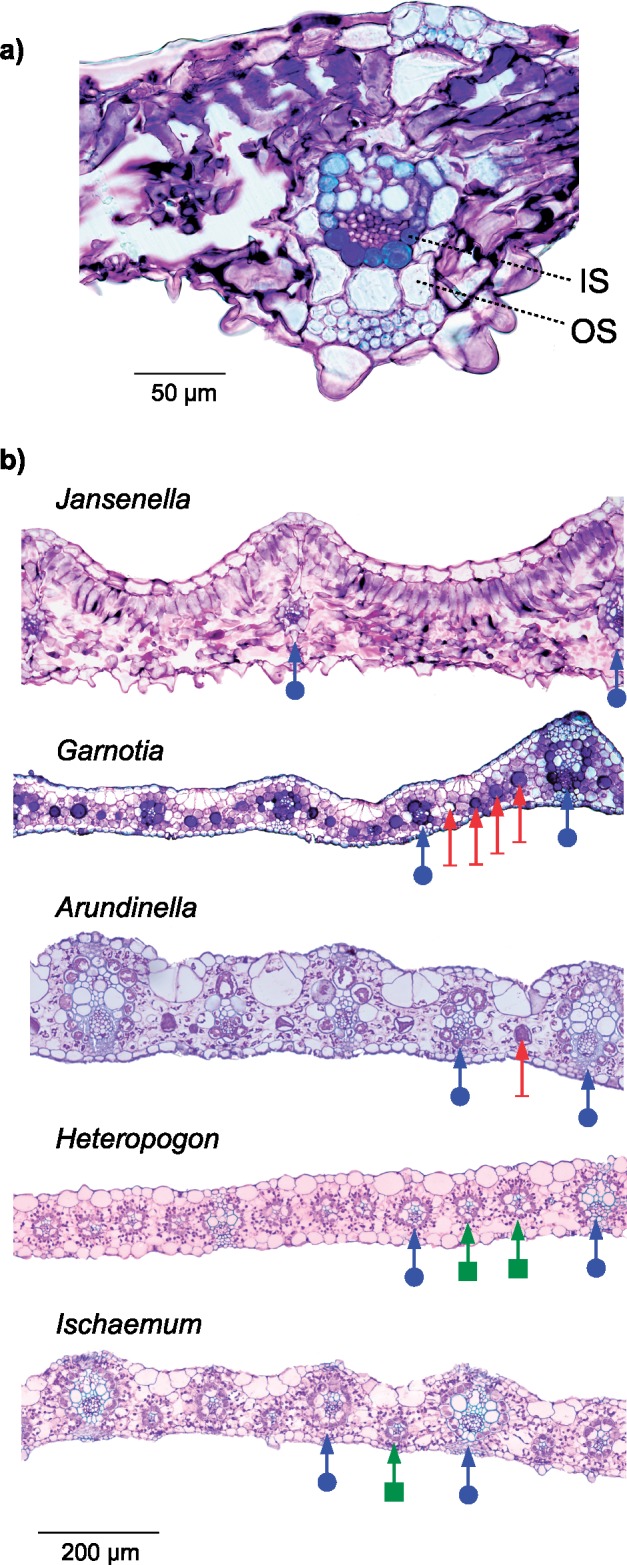
Leaf transverse sections of representatives of Jansenelleae and Andropogoneae. a) Jansenella griffithiana. IS, inner bundle sheath; OS, outer bundle sheath. Scale bar = 50 \documentclass[12pt]{minimal}
\usepackage{amsmath}
\usepackage{wasysym}
\usepackage{amsfonts}
\usepackage{amssymb}
\usepackage{amsbsy}
\usepackage{upgreek}
\usepackage{mathrsfs}
\setlength{\oddsidemargin}{-69pt}
\begin{document}
}{}$\mu $\end{document}m. b) Jansenella griffithiana, Garnotia stricta, Arundinella nepalensis, Heteropogon contortus, and Ischaemum afrum. The latter three images are from Christin et al. (2013). Arrows with a circle, a dash and a square indicate major veins, distinctive cells, and minor veins, respectively. Scale bar = 200 \documentclass[12pt]{minimal}
\usepackage{amsmath}
\usepackage{wasysym}
\usepackage{amsfonts}
\usepackage{amssymb}
\usepackage{amsbsy}
\usepackage{upgreek}
\usepackage{mathrsfs}
\setlength{\oddsidemargin}{-69pt}
\begin{document}
}{}$\mu $\end{document}m.